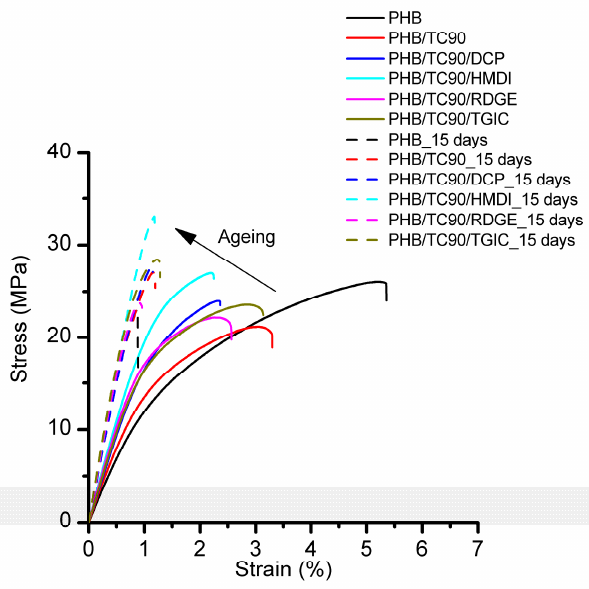
Figure 3. Representative stress–strain curves of neat PHB and PHB / TC90 composites at 0 days (solid lines) and after 15 days of aging (dashed lines). Table 3. Mechanical parameters corresponding to tensile tests.